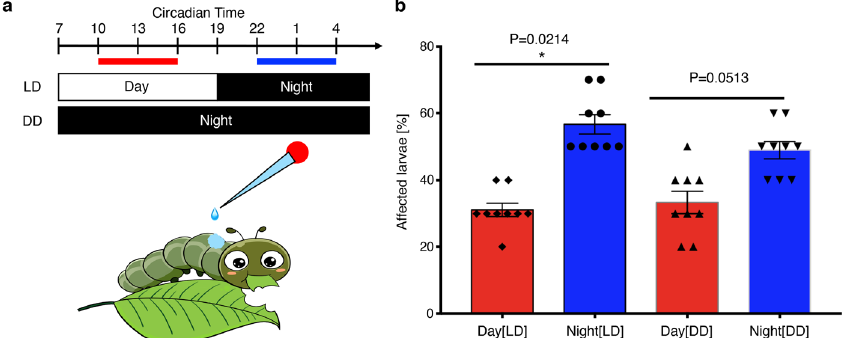
Fig. 7 Topical treatment of imidacloprid on 4th instar larvae. a Outline of day – night settings and timing of imidacloprid treatment. b The effect of imidacloprid exposure on normal larvae. The experiments were performed during daytime (10 a.m. – 4 p.m., red) and night (10 p.m. – 4 a.m., blue) in normal LD (12 h:12 h) and DD (continued darkness) conditions based on a preliminary LD 50 test (see Methods). Larvae were scored as “ affected ” when they rounded up, stiffened and did not move when touched, as if dead ( “ suspended animation ” ). Three groups of 10 4LD2 larvae were used; each group was treated once during the day or night. The mean percentage of larvae affected after direct exposure to imidacloprid solution on their dorsal surface is shown ± SEM with three repeated tests and statistically signi fi cant difference was set at * P value < 0.05, ** P value < 0.01 and *** P value <